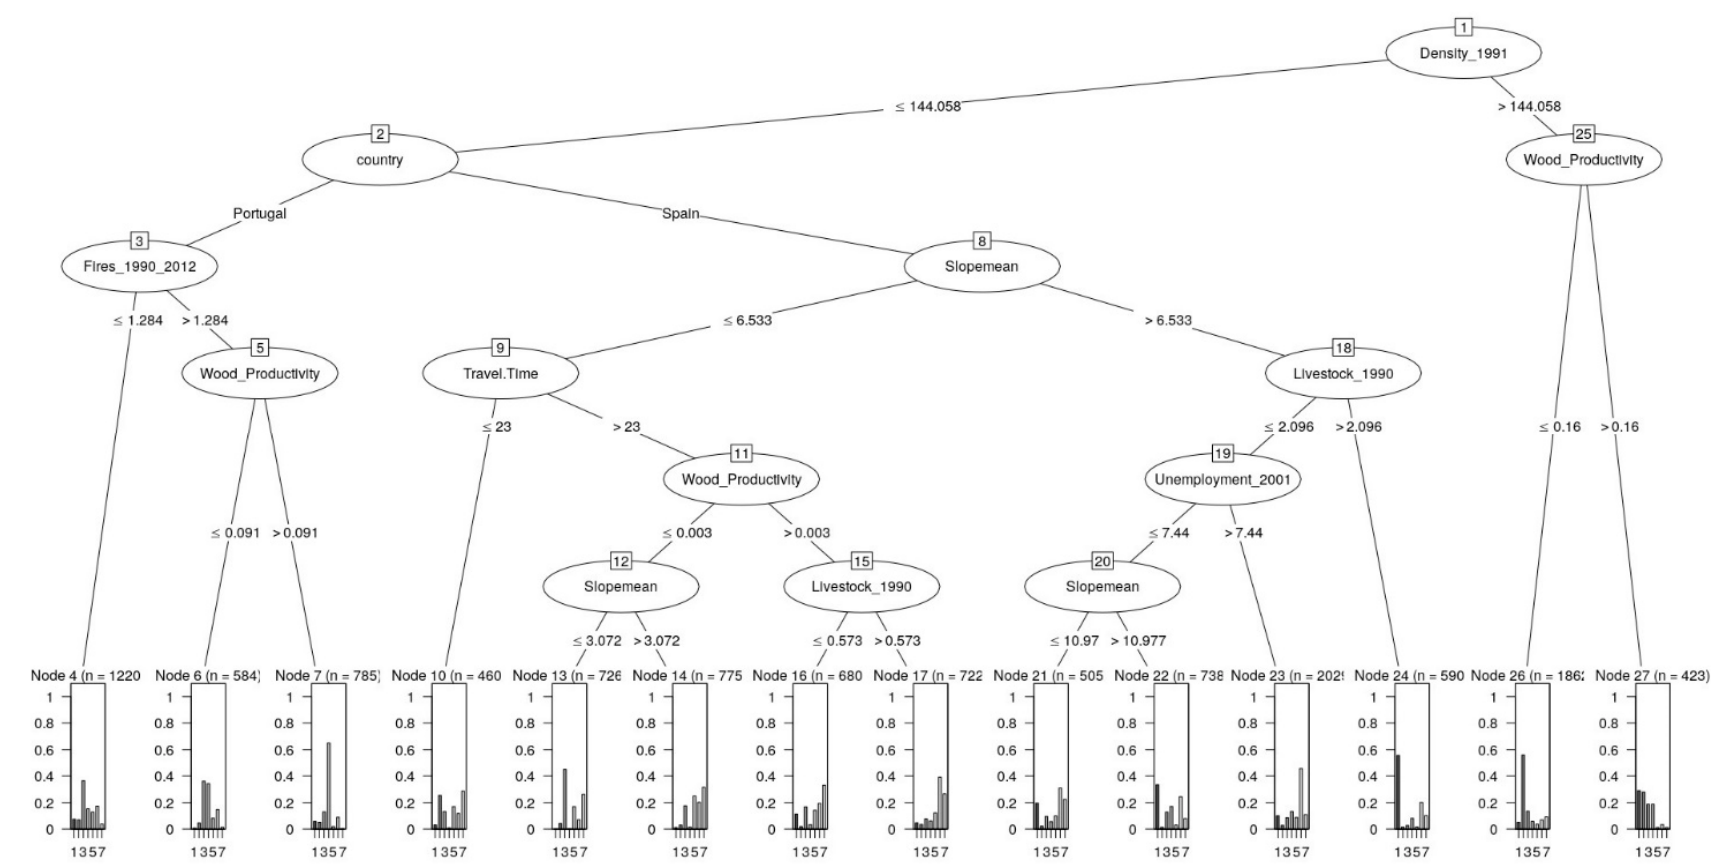
Figure 2. Resulting decision tree. The bar diagrams at the bottom represent the distribution of administrative units depending on dominant land use/cover process.